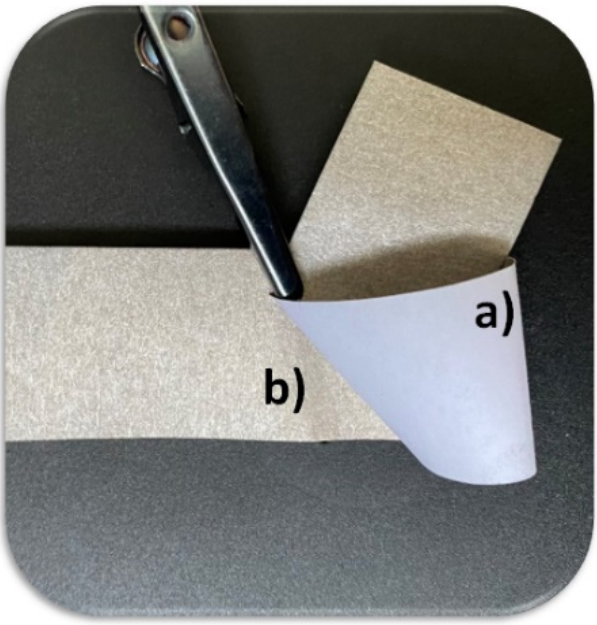
Figure 1. Picture of the curved paper substrate ( a ) uncoated and ( b ) coated with a C–Ag nanocom- posite thin film on the paper.